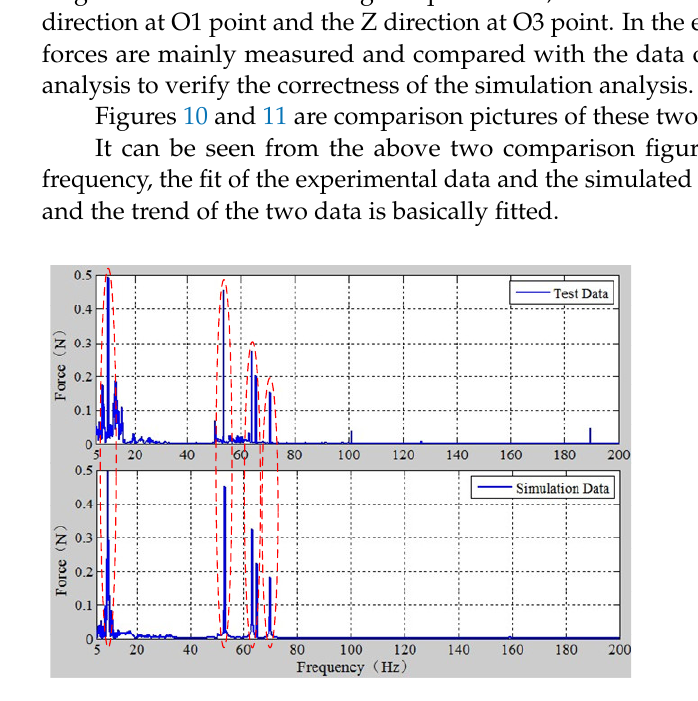
Figure 11. Test and simulation data comparison of Z-direction reaction force at O3 point. It can be seen from the above two comparison figures that at the corresponding fre- quency, the fit of the experimental data and the simulated data can reach more than 90%, and the trend of the two data is basically fitted. Compared with the simulated data, the experimental data has more peaks. This is because the data collected during the experiment contains noise, which is obvious in the low frequency range. At the same time, the experimental data is smaller. The reason is that the suspension mode is used to simulate the non-gravity environment in space un- der the test conditions. The suspension device bears a certain vibration input, which is also in line with expectations. 5. Results Based on the traditional transfer path analysis, this paper adopts the modal super- position method and the penalty function method to establish an improved reaction force transfer path analysis method. This method is suitable for the vibration reduction analysis of the mechanical system in the design stage because there is no need to consid- er the structural parameters of the next system, and this method has a greater advantage in solving speed. In this paper, by analyzing the transfer path of the force for the vibration damping design of a satellite refrigeration module by the research group, the output point posi- tions with unsatisfactory vibration damping efficiency are identified, and the path con- tribution of these positions is analyzed. Through analysis, we can identify the main fac-